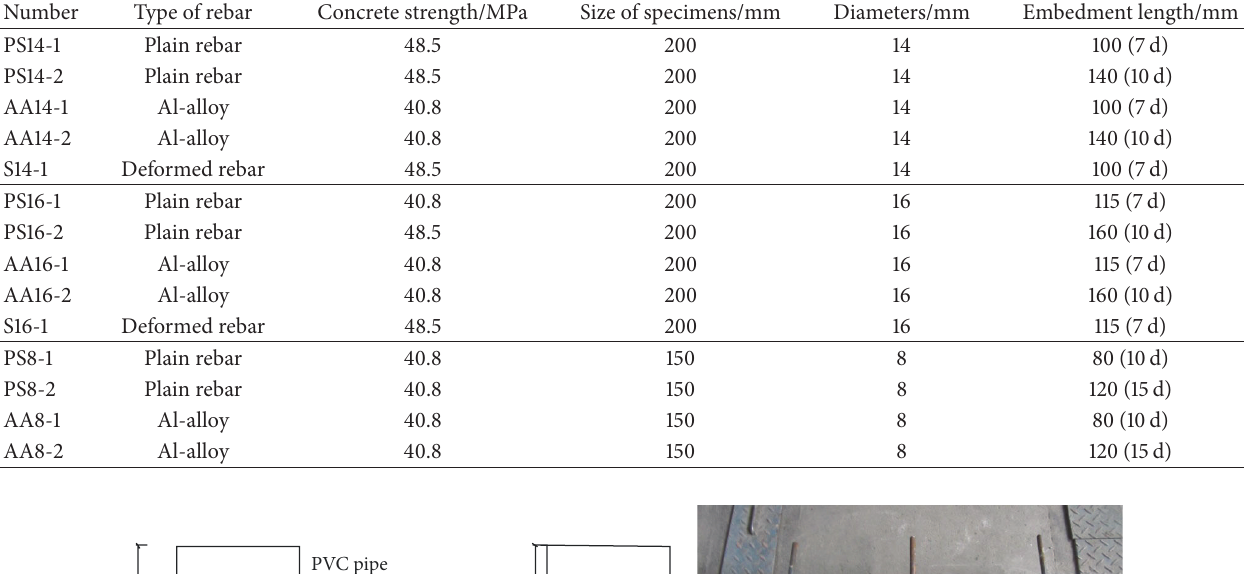
Table 2: Parameters of test specimens.